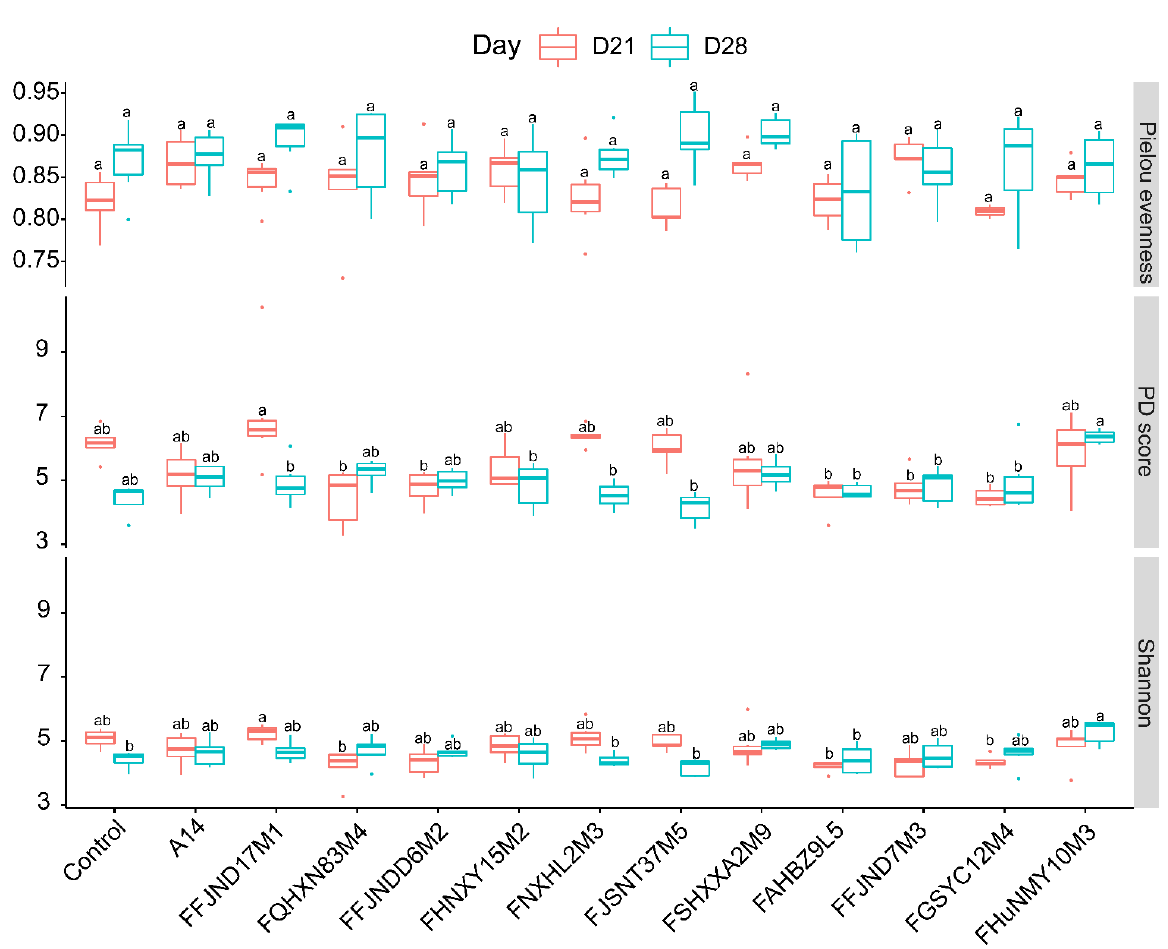
Figure 6. Relative abundance of B. pseudocatenulatum species in total Bifidobacteria among different mice groups at different time points (( a ): 21 days; ( b ): 28 days). The t -test p -values show that this variation was statistically significant ( t -test p < 0.05).